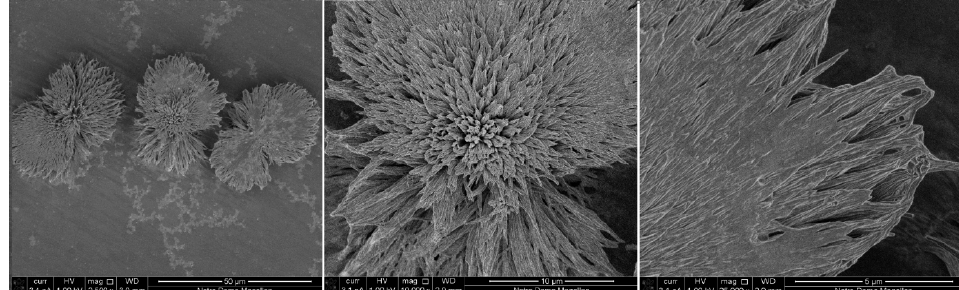
Figure 2. SEM images of the M crystals shown with different magnification.